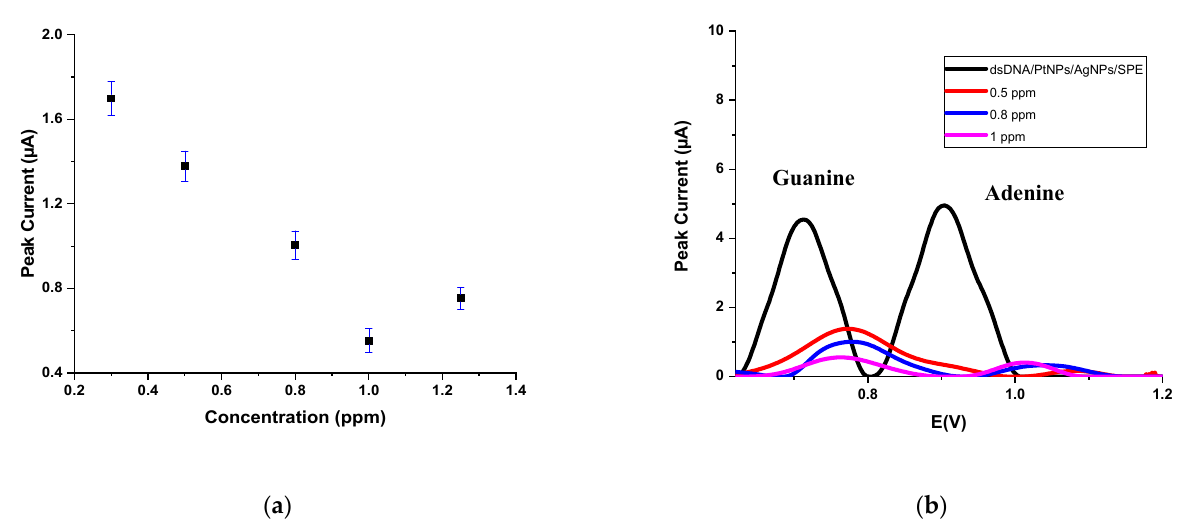
Figure 5. ( a ) The effect of EPI concentration on the signal of dGuo; ( b ) DP voltammograms of dsDNA/PtNPs/AgNPs/SPE (black) with different EPI concentration in pH 4.70 AB; 0.5 ppm (red), 0.8 ppm (blue), 1 ppm (pink).